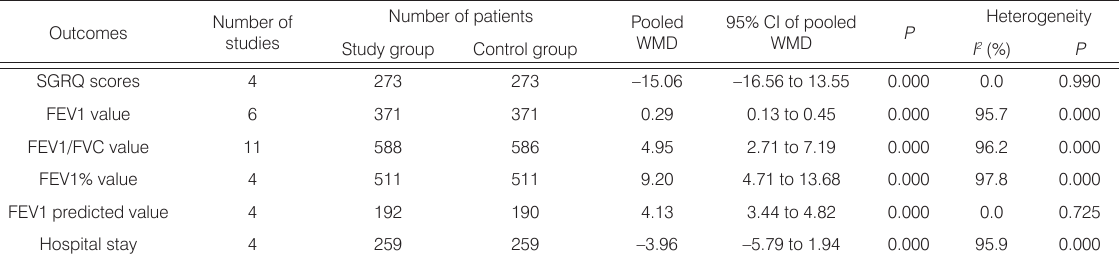
Table 2. Results of meta-analysis